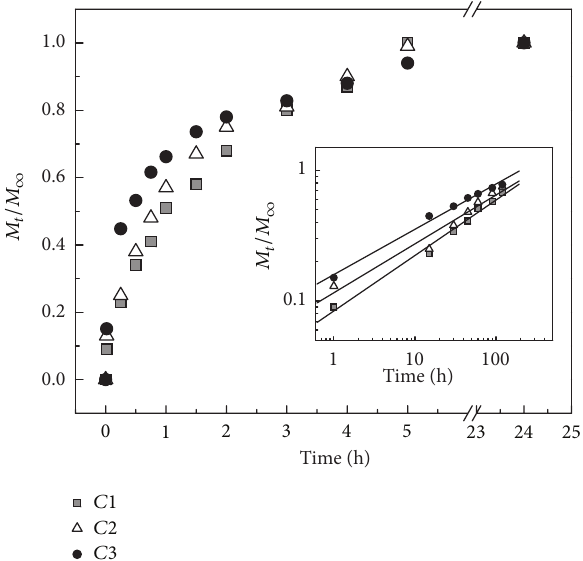
VOAsc) membrane at a temperature of 37 ∘ C before (black) and after (red) a 24 h wash of the membrane in distilled water.